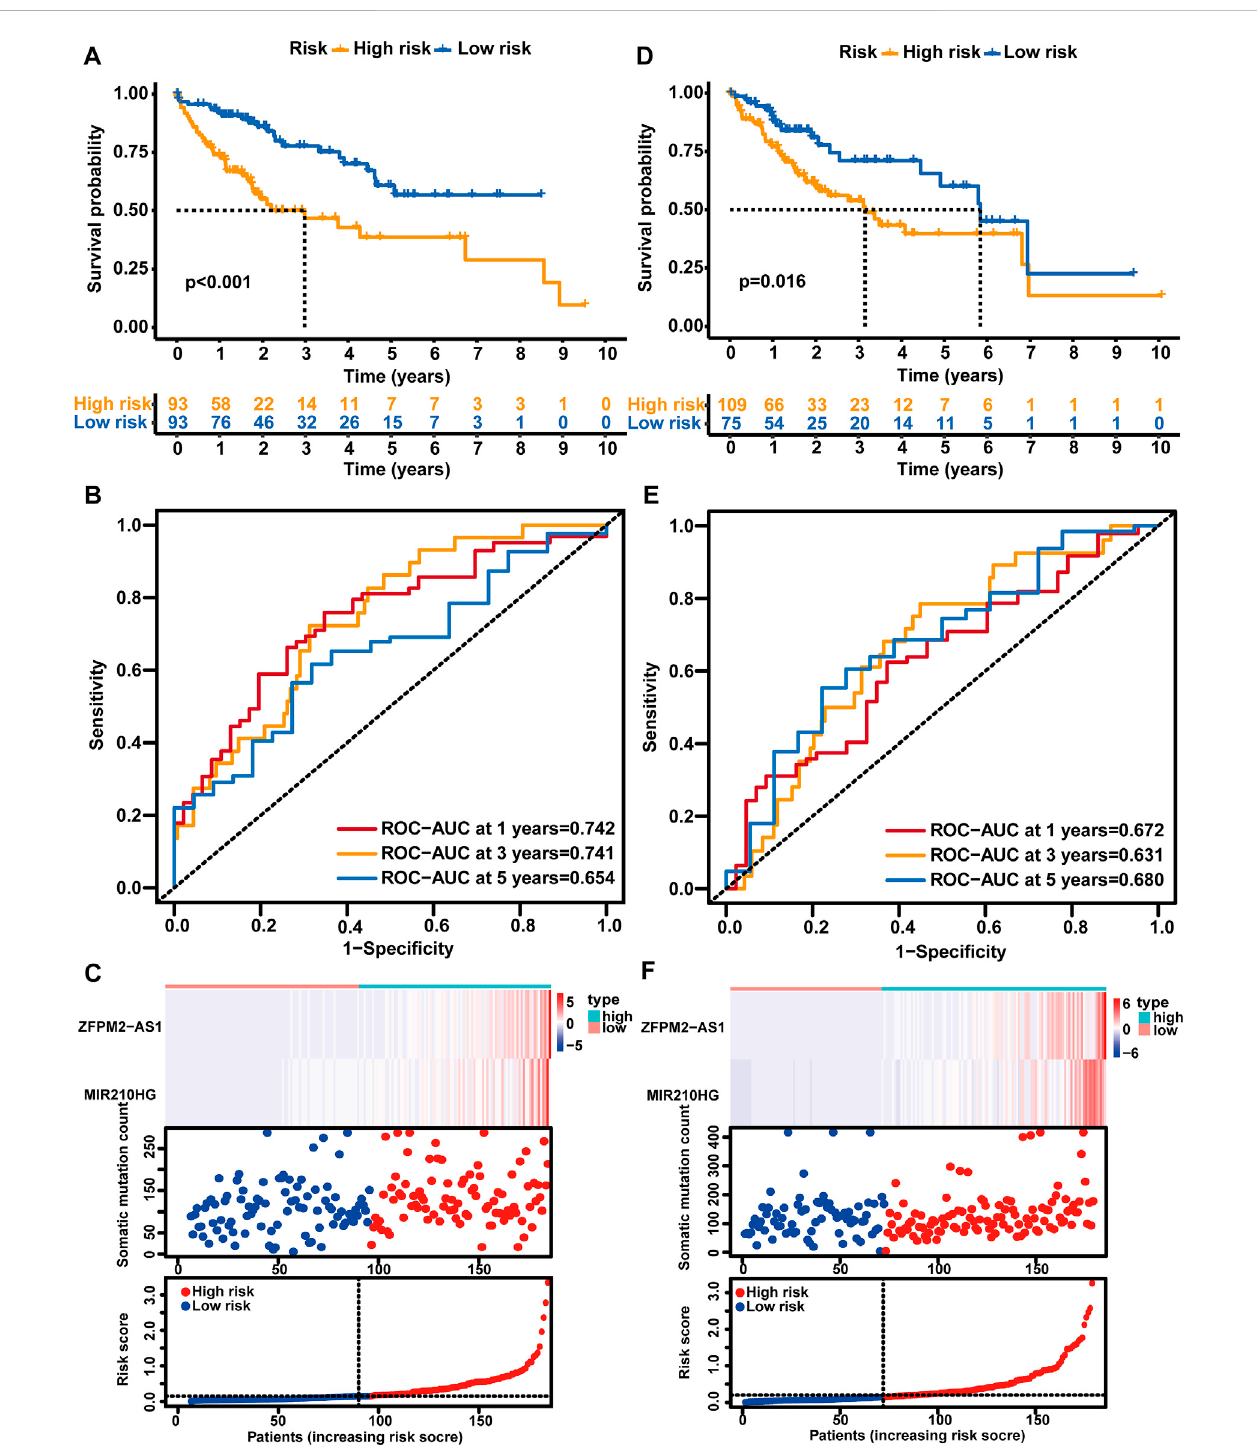
FIGURE 3 Analysis of the prognostic performance of the GLncM. Kaplan ‒ Meier survival analysis of the OS of the high-risk and low-risk groups predicted by the GLncMinthetraininggroup (A) andveri fi cationgroup (D) .Thelog-ranktestwasappliedforthestatisticalanalysis. (B) and (E) Time-dependentROCcurvesfor the analysis of the performance of the GLncM at 1, 3, and 5 years in the training group and veri fi cation group, respectively. (C) and (F) The lncRNA expression pro fi les, the risk score and the landscape of mutation counts in the training group and veri fi cation group. GLncM: genomic instability-related lncRNA model; OS: overall survival; ROC: receiver operating